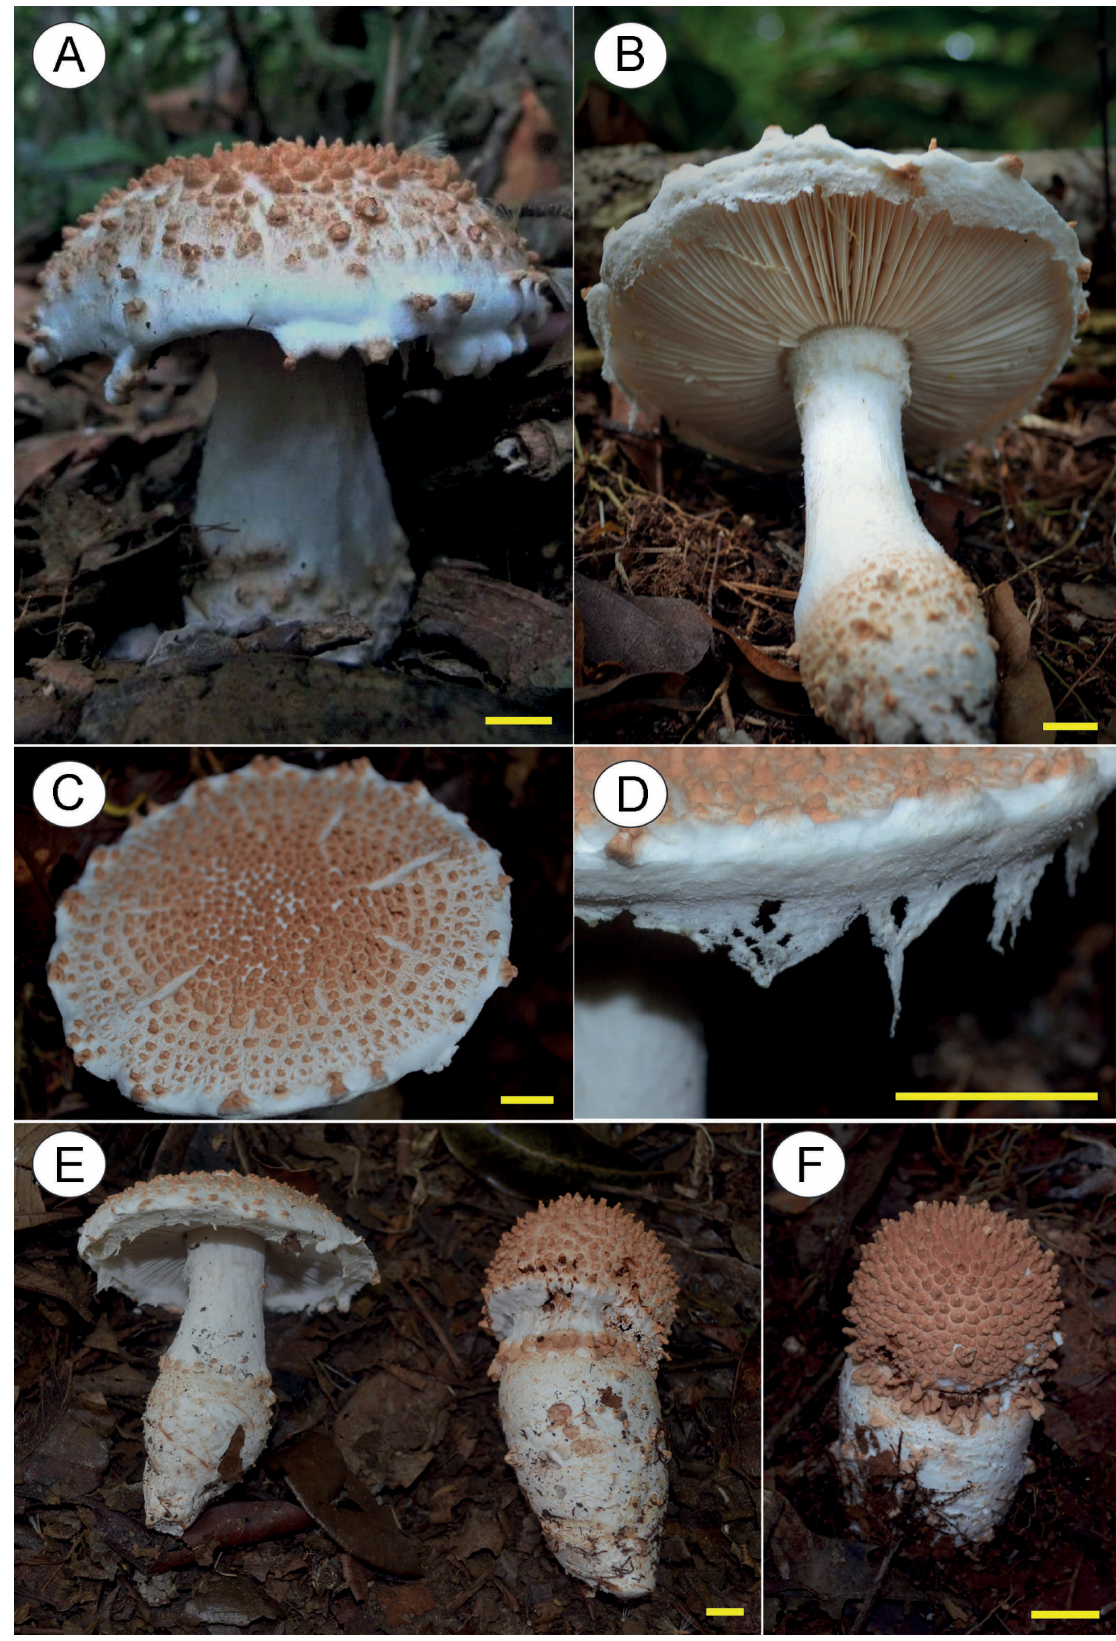
Figure 1 – Amanita dulciodora : A–F, young and mature basidiomata. Scale bars = 10 mm. Photographs by F.